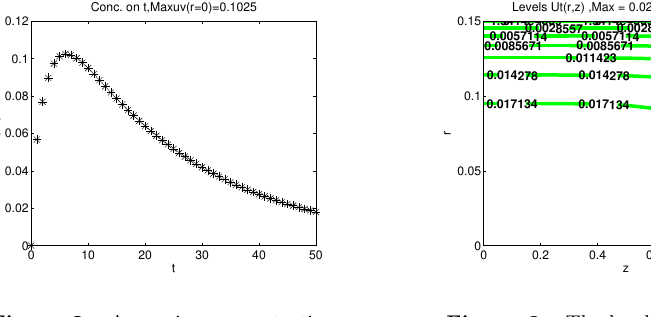
Figure 3. The levels of concentration u ( r,z,t f ) for t f =